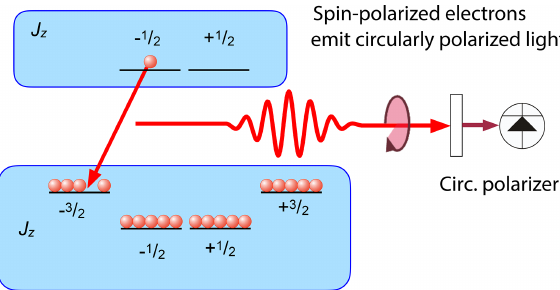
Figure 23. Photoluminescence (PL) from a semiconductor quan- tum well when the charge carriers are partly spin-polarized. For the case shown here, the emission perpendicular to the well is circularly polarized.